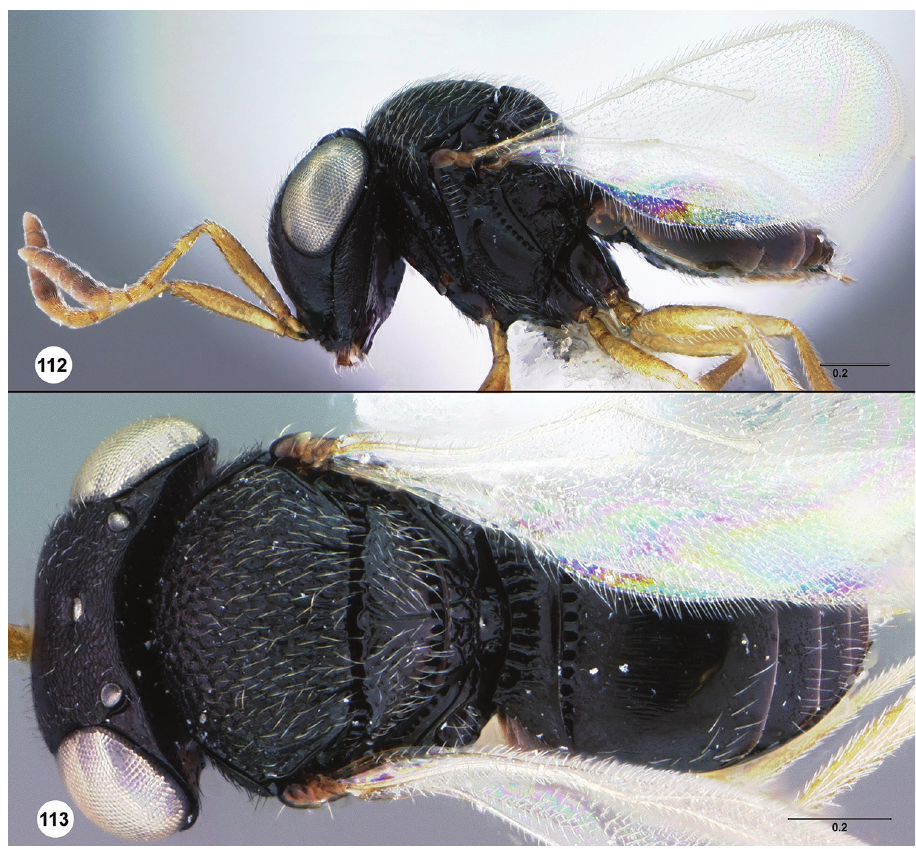
Figures 112–113. Trissolcus nycteridaner , female holotype (USNMENT00896182) 112 head, meso- soma, metasoma, lateral view 113 head, mesosoma, metasoma, dorsal view. Scale bars in millimeters. Facial striae: absent. Number of clypeal setae: 2. Microsculpture on gena directly above mandibular condyle: absent. Shape of ventral gena in lateral view: narrow. Genal ca- rina: absent. Malar striae: absent. Sculpture of malar sulcus: faintly rugulose. Orbital furrow: expanding in size ventrally, strongly so at intersection with malar sulcus. Mac- rosculpture of frons between antennal scrobe and anterior ocellus: absent. Preocellar pit: present. Setation of lateral frons: moderately dense. Punctation of lateral frons: moderately dense. Macrosculpture of lateral frons: absent. OOL: separated by less than one ocellar diameter. Hyperoccipital carina: complete. Macrosculpture of posterior vertex: absent. Microsculpture on posterior vertex along occipital carina: absent. Ante- rior margin of occipital carina: coarsely crenulate. Mesosoma. Epomial carina: present. Macrosculpture of lateral pronotum directly anterior to netrion: rugose. Netrion sulcus: incomplete. Pronotal suprahumeral sul- cus in posterior half of pronotum: undifferentiated from sculpture of dorsal prono- tum. Number of episternal foveae: 3; 4 or more. Course of episternal foveae